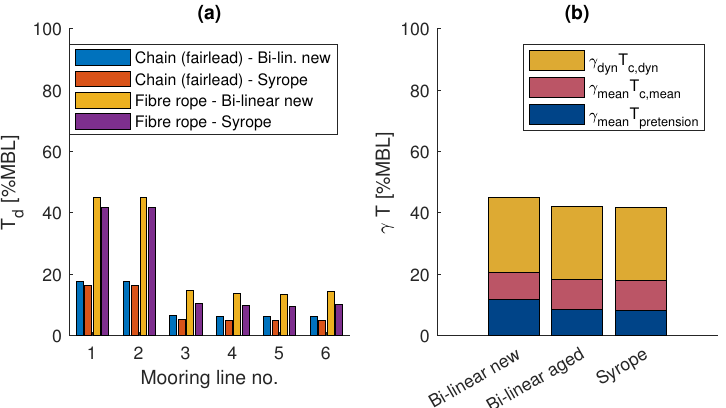
Figure 15. ( a ) ULS design tension in the fairlead chain and fibre rope when applying the bi-linear and Syrope models. ( b ) Contribution to the design tension from pretension, mean environmental loads and dynamic